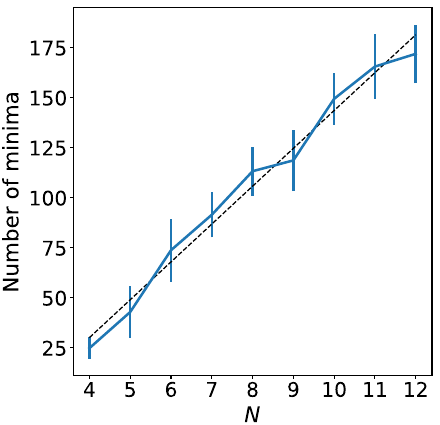
FIG. 8. Number of stable configurations in a network of linear springs grows linearly with the size of the